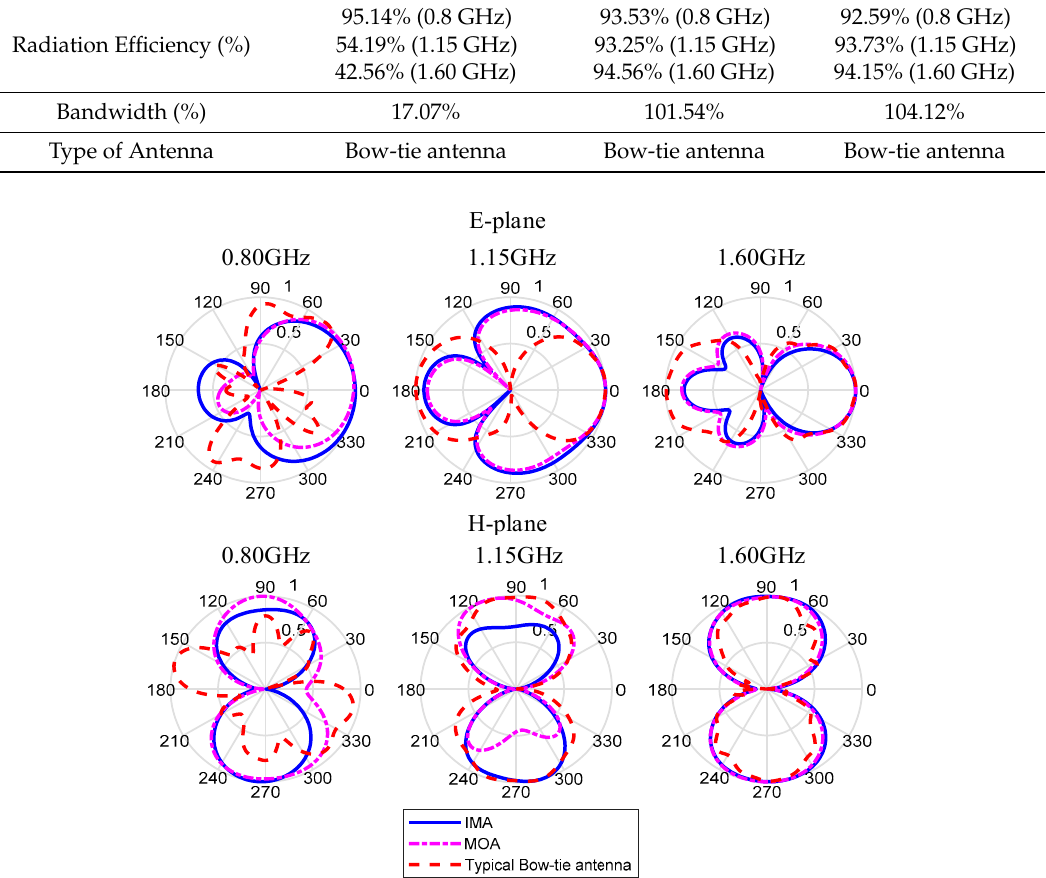
Figure 1. The E-plane and H-plane radiation pattern of typical Bow-tie antenna, MOA, and IMA.